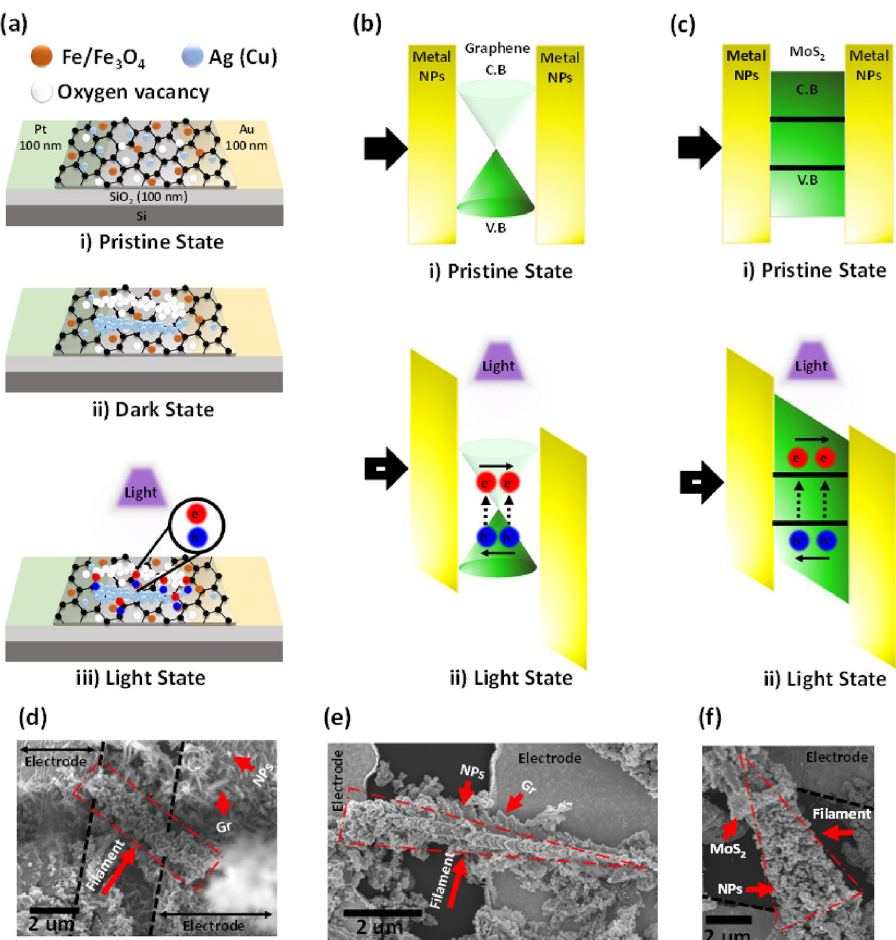
Figure 6. Schematic diagrams of the switching performance corresponding to the various states of a 2D materials-based memristor device doped with NPs, schematic energy band diagram in dark state and under light illumination and SEM images. ( a ) (i) The pristine state in which the device is in high resistance state (OFF state). A random distribution of NPs on the 2D flakes can be observed. (ii) The set state (ON state) occurs